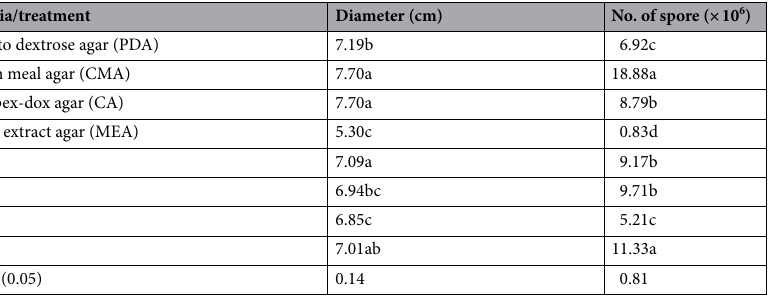
Table 4. Effect of growth medium and light cycle on Exserohilum rostratum , fungal pathogen. Treatments are denoted as CMA supplemented E. rostratum under the following light cycles: T1; 12 h fluorescent light + 12 h black light, T2; 12 h fluorescent light + 12 h complete darkness, T3; 12 h black light + 12 h complete darkness , and T4; 24 h darkness. * Means in column with different alphabets are significantly different at p ≤ 0.05, Fisher’s least significant difference